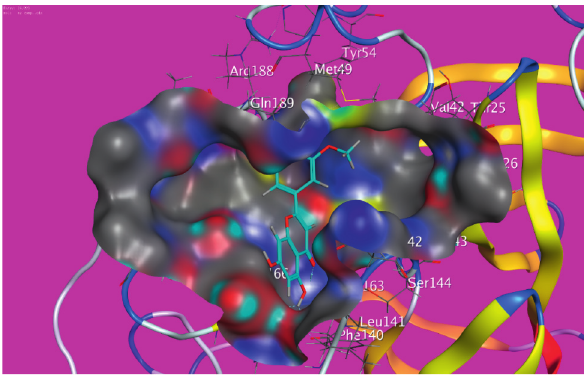
Figure 6: Mapping surface showing compound (2) occupying the active pocket of the COVID-19 main protease.